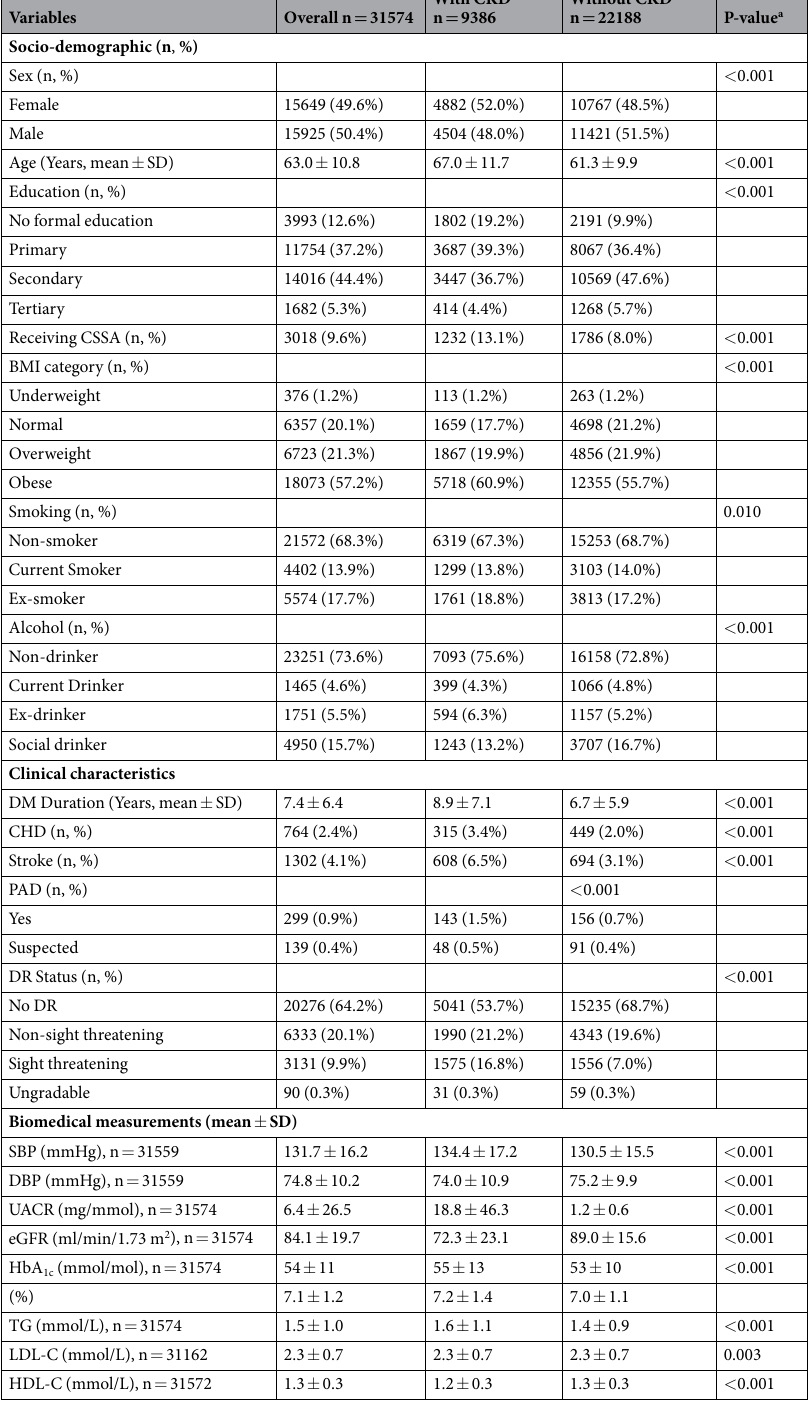
Table 1. Descriptive statistics of demographic and clinical characteristics of all the people with type 2 diabetes, those with and without chronic kidney disease (CKD). a P-Value of Chi-square test for categorical data and of Mann-Whitney test for continuous